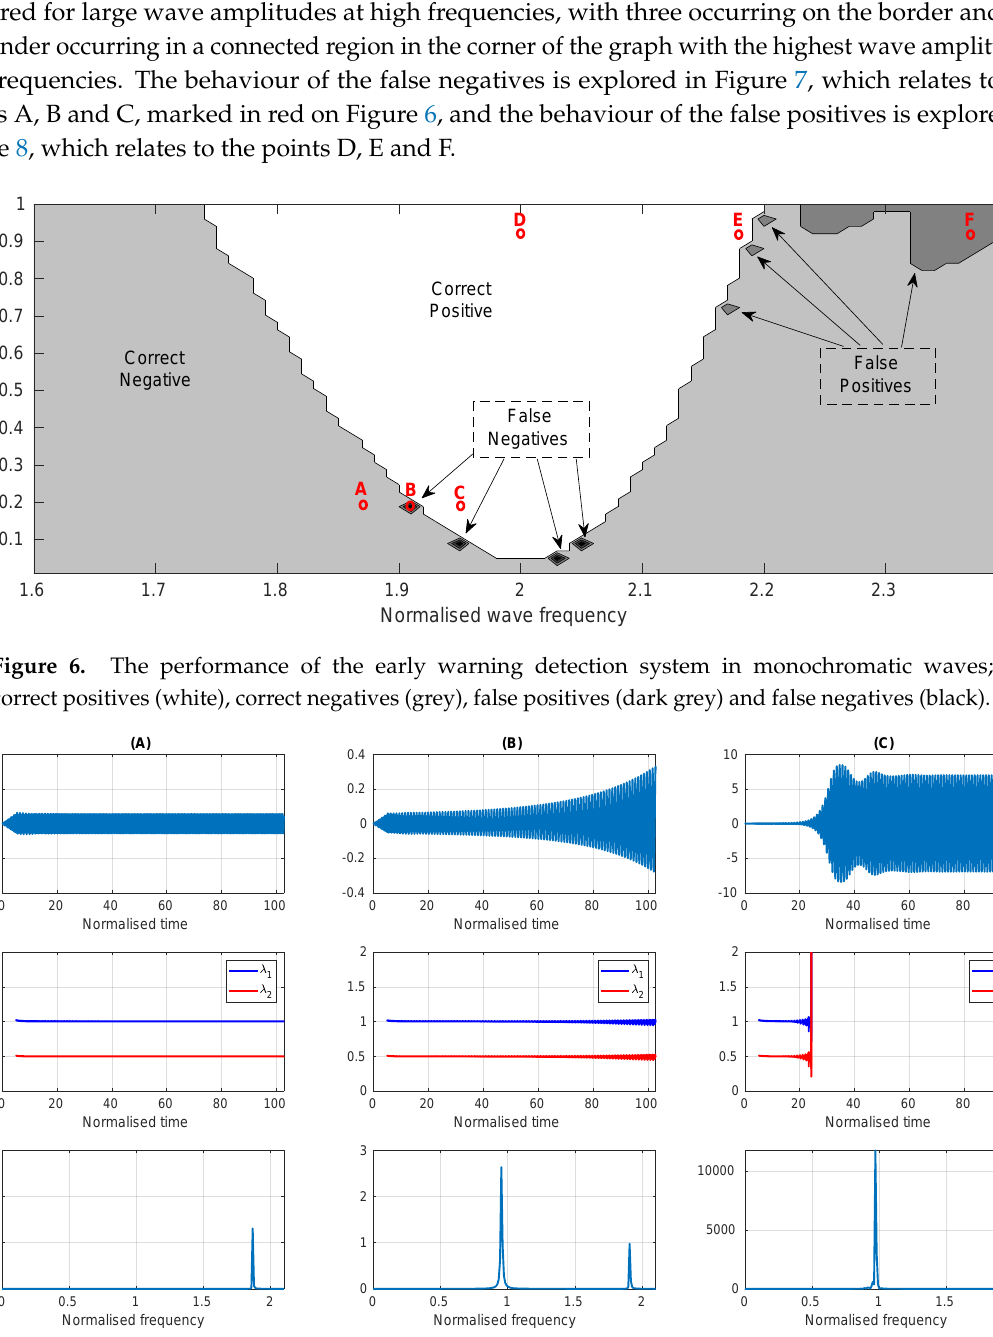
Figure 7. The pitch displacement time series ( top ), the magnitudes of the eigenvalues of the matrix A ( middle ) and the PSD of the pitch displacement ( bottom ), for the points (A) A, (B) B and (C) C in Figure